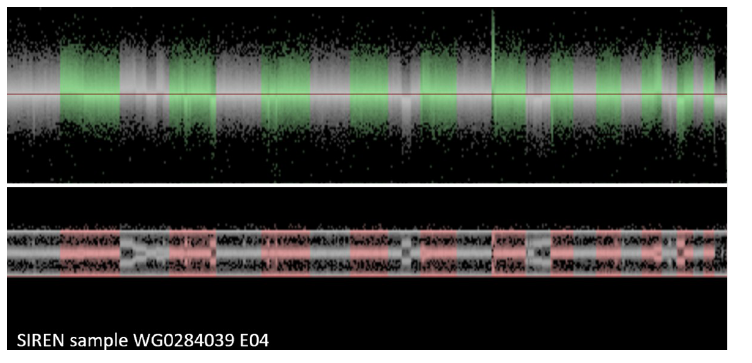
Fig 7. SIREN participant sample with clonal